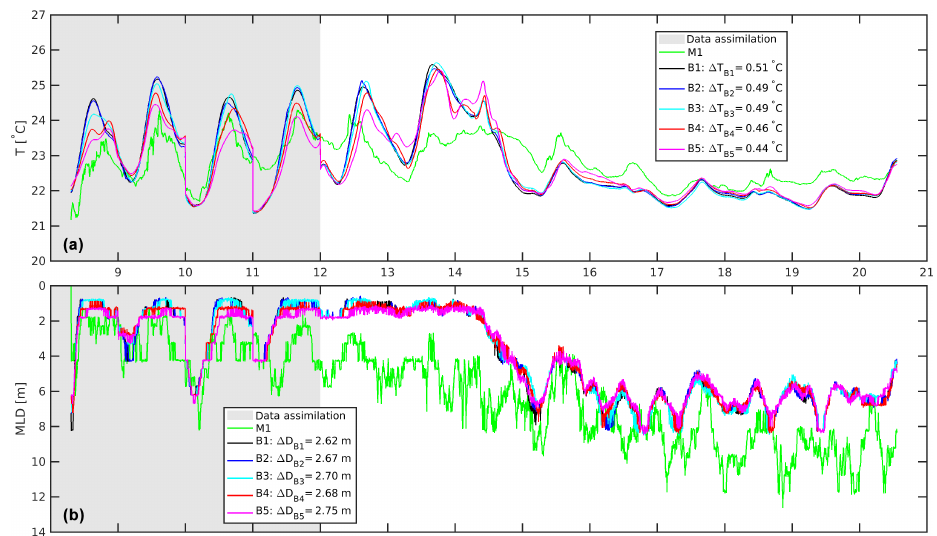
Figure 12. ROMS runs B1–B5: the time series of (a) the near-surface temperature at 0.81m of depth, (b) the mixed-layer depth (MLD), and the corresponding observations at mooring M1. The numbers on the abscissae indicate June dates. The period for which the data are assimilated is highlighted with grey shading.